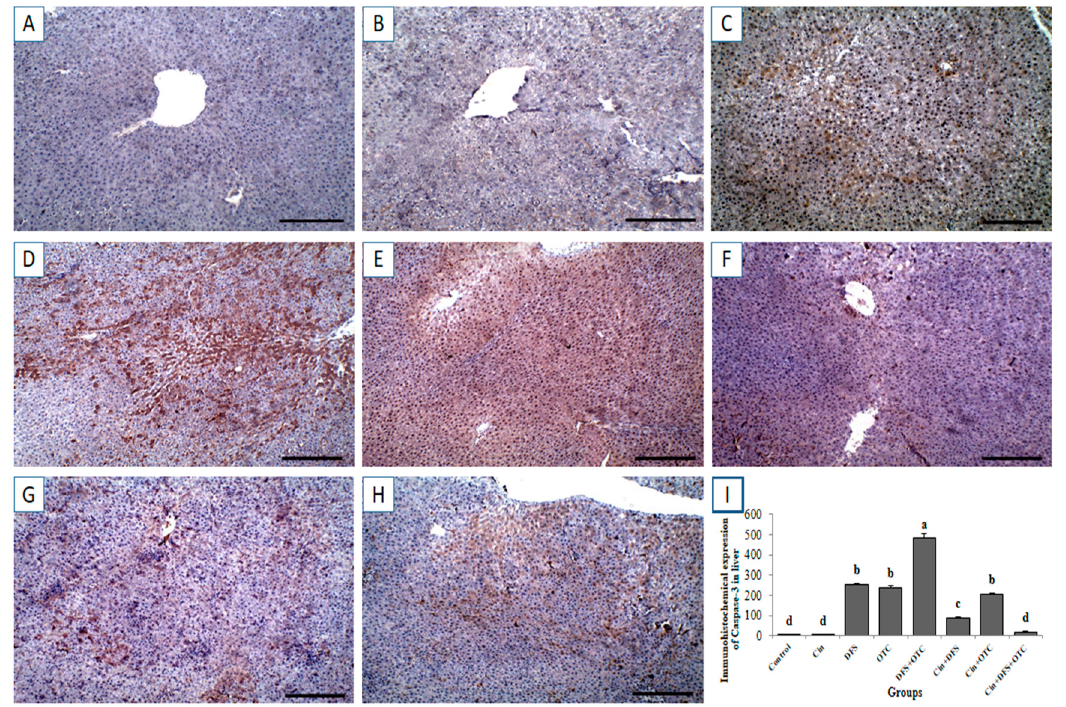
Figure 6. Immunohistochemical staining of rat liver by caspase-3. ( A , B ) control and cinnamon groups: Showing negative caspase-3 reaction in the liver sections. ( C , D ) DFS and OTC groups: Revealing strong positive caspase-3 reaction in the hepatocytes. ( E ) DFS + OTC group: Showing higher expression levels of caspase-3 relative to those in rats treated with DFS or OTC alone ( F ) DFS+ Cin group: Revealing weak caspase-3 reaction. ( G ) OTC + Cin group: strong caspase-3 positive reaction. ( H ) DFS + OTC + Cin group: Showing reduction in caspase-3 reaction compared to DFS + OTC group. ( I ) Quantification of caspase-3 in the liver tissues in different groups. Data are presented as the mean ± SEM (n = 5), analyzed using one way ANOVA and each bar carrying different letters (a, b, c, d) is significantly different ( p < 0.05). Scale bar = 100 µm.